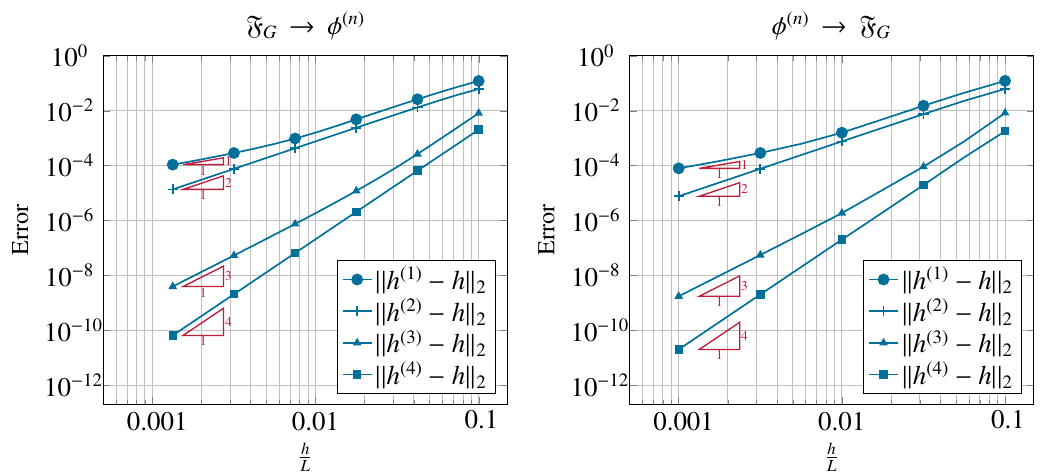
Figure 3. Gyroid convergence study. In both panels, the error in the measured offset h m is plotted against different predefined normalized offsets. In the left figure, the offsets were measured starting from points on F G ( (cid:126) x ) = 0 to points on each surface φ ( n ) ( (cid:126) x , h ) = 0, respectively. In the right figure, the measurement direction is reversed. The triangles represent the corresponding slope for each order n .